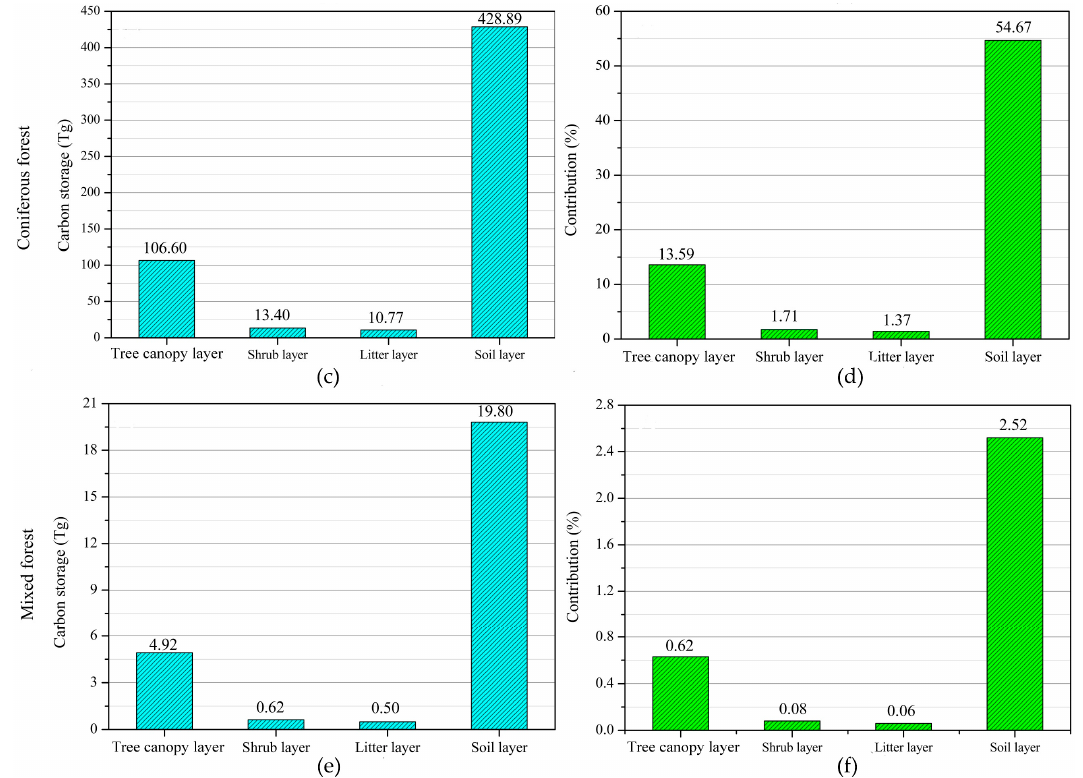
Figure 7. Carbon storage (Tg) in Hubei Province ( a , c , e ) and contribution rates ( b , d , f ) of different layers in different types of forests to the total carbon storage in the study